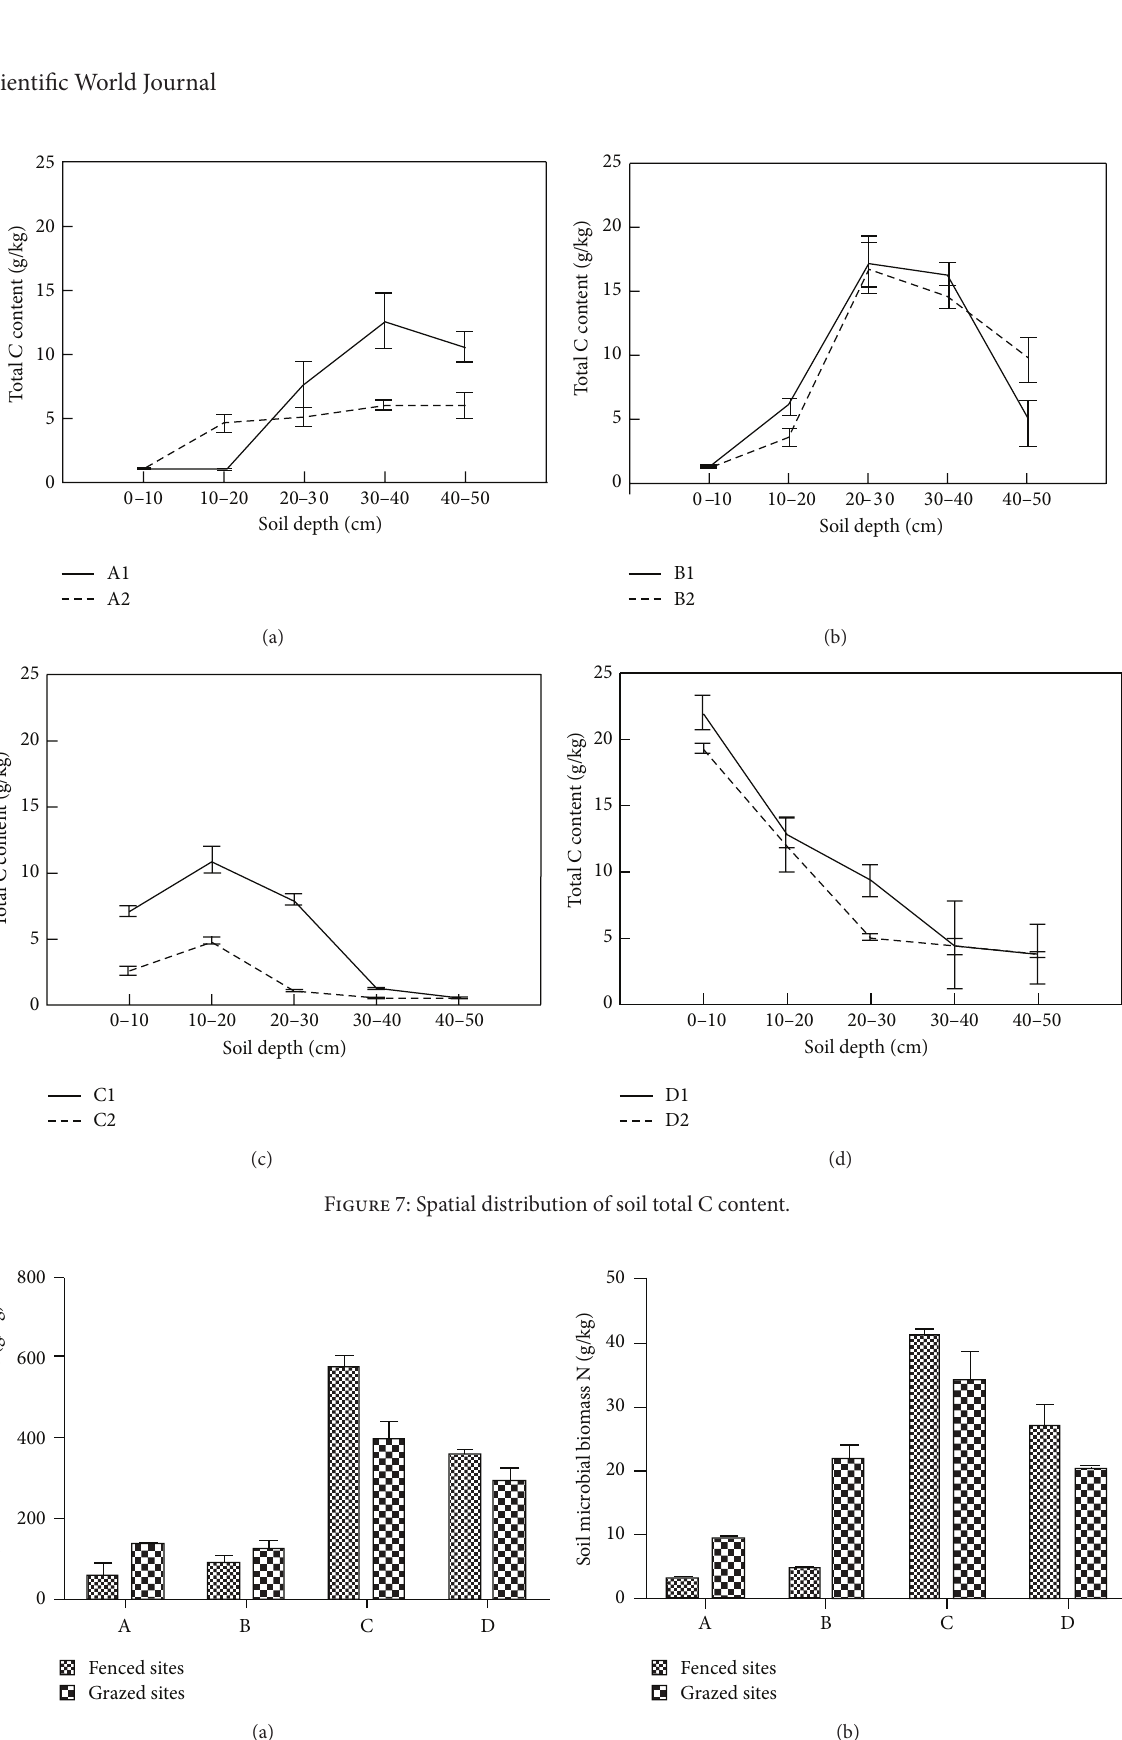
Figure 8: Spatial distribution of soil microbial biomass C and